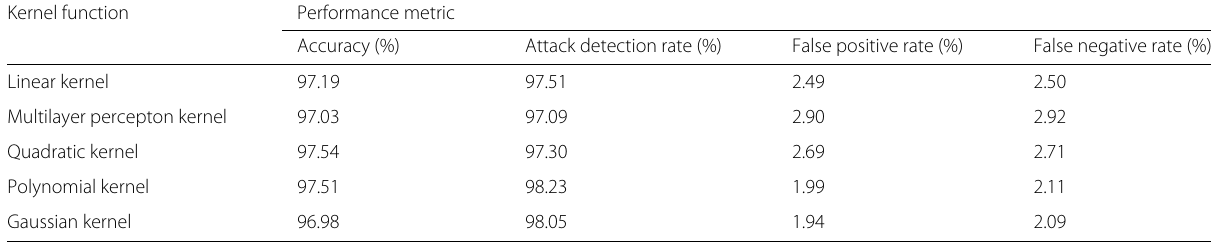
Table 8 Kernel functions comparison using the proposed detection approach Kernel function